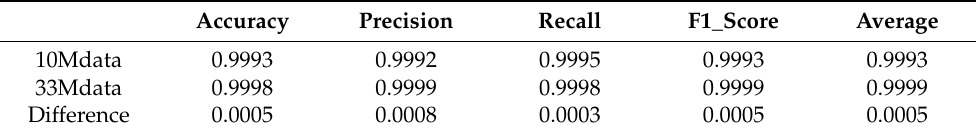
Figure 28. Performance comparison with changing DDoS dataset.